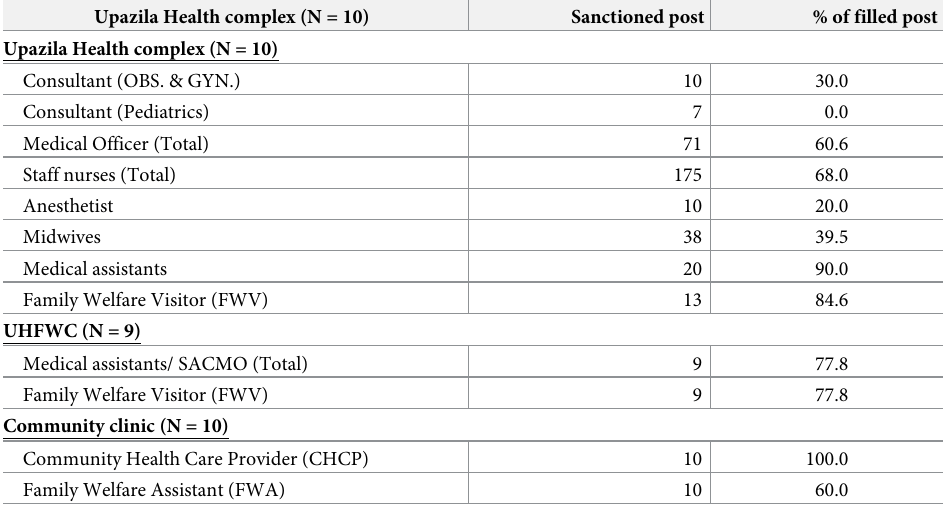
Table 4. Available human resources against sanctioned post in the study